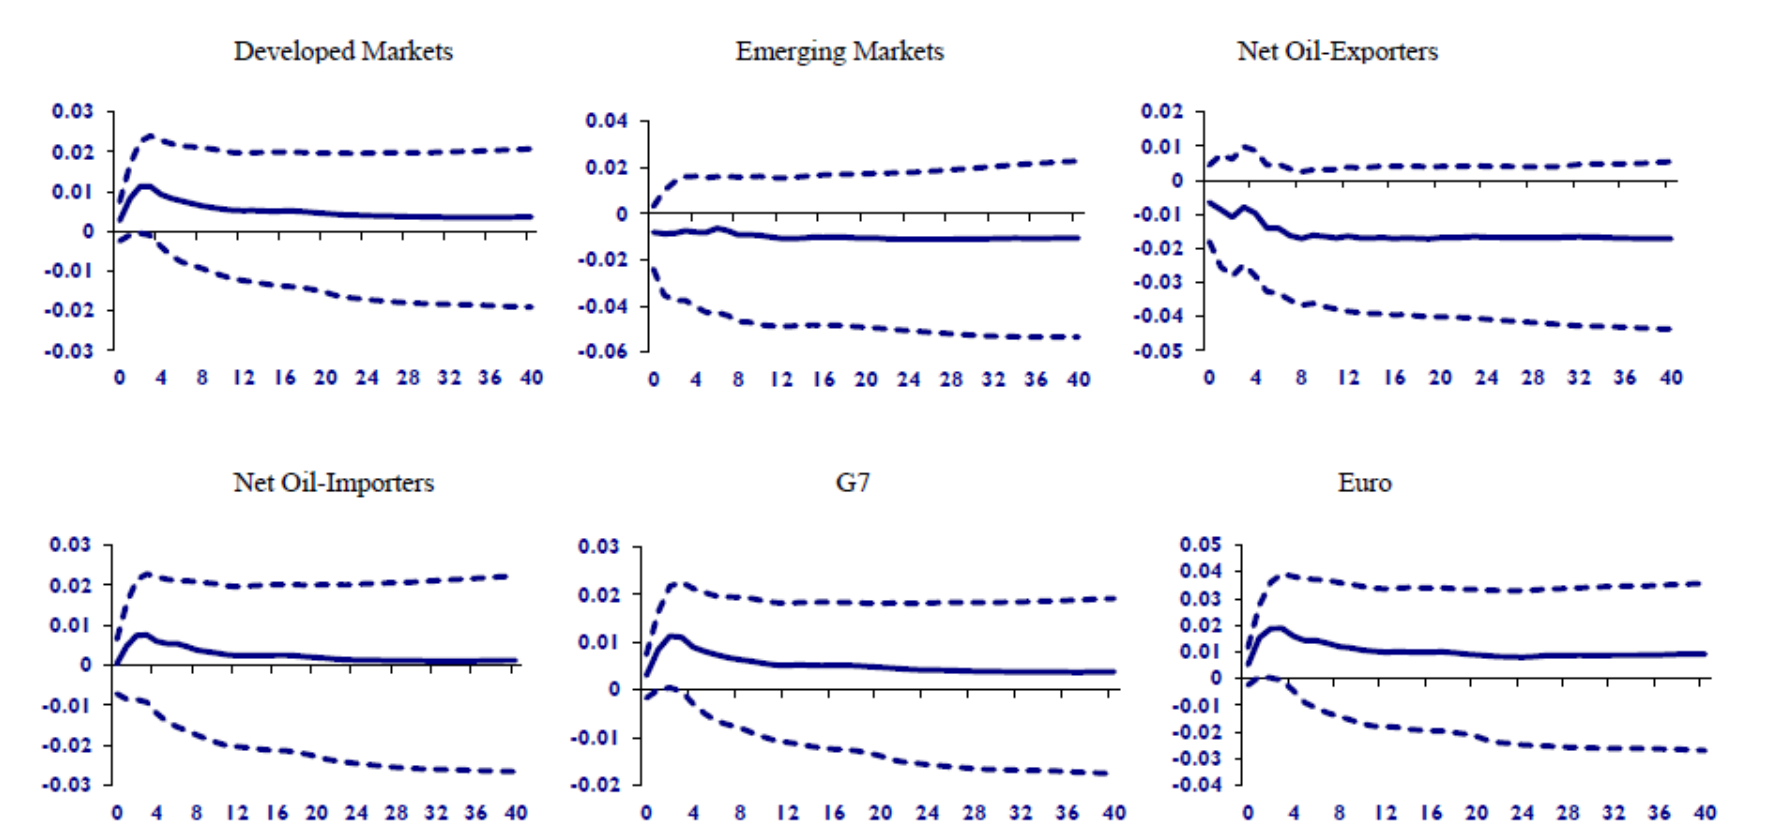
Figure 4. Country group oil price uncertainty shocks and real stock prices ( pre-gfc ). Note: The figure depicts the impulse response functions of real stock prices of country groups to a one standard deviation increase in oil price uncertainty. The median impulse response is presented in solid lines, while the 16–84% lower and upper bootstrapped error bands are shown in dotted lines. The impact is measured in percentage points (by multiplying the estimates in the figure with 100) over the quarterly horizon.